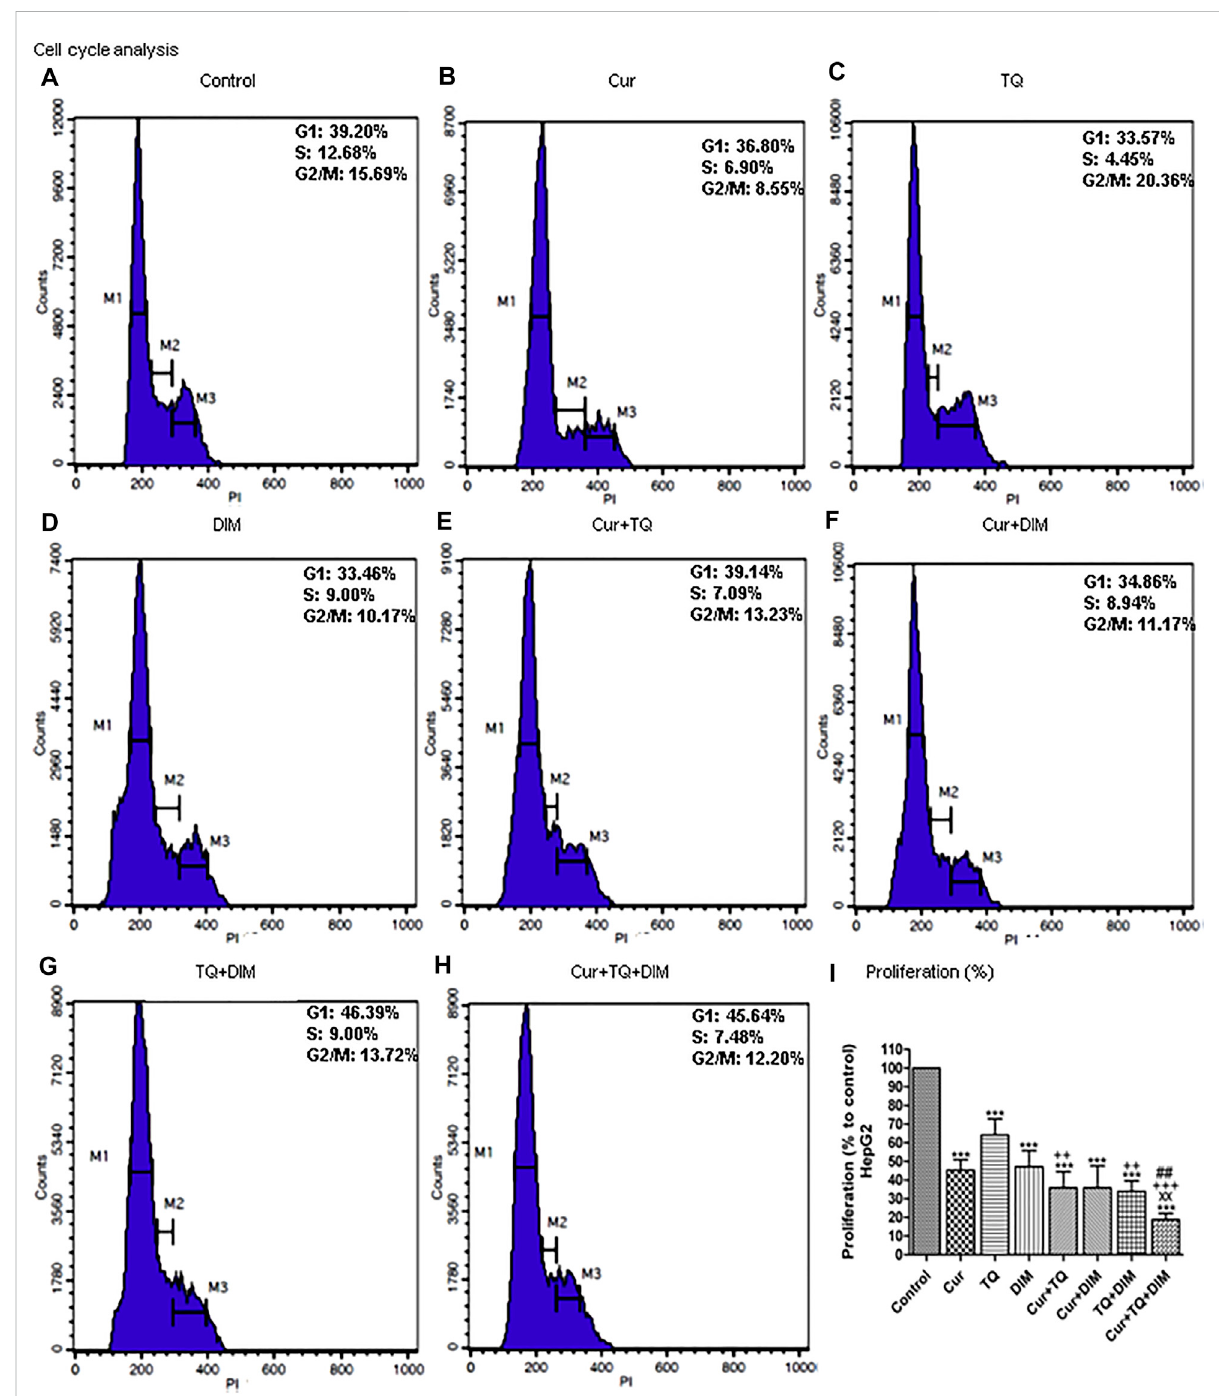
FIGURE 7 Cell cycle analysis and proliferation percentage of HepG2. (A) Cell cycle analysis of control HepG2. (B) Cell cycle analysis of Cur-treated cells with 0.75 (Fa 95) = 15.83 µM. (C) Cell cycle analysis of TQ-treated cells with 0.75 (Fa 95) = 18.71 µM. (D) Cell cycle analysis of DIM-treated cells with 0.75 (Fa 95) = 42.27 µM. (E) Cell cycle analysis of Cur + TQ treated cells with 0.75 (Fa 95) of Cur and TQ. (F) Cell cycle analysis of Cur + DIM treated cells with 0.75 (Fa 95) of Cur and DIM. (G) Cell cycle analysis of TQ + DIM treated cells with 0.75 (Fa 95) of TQ and DIM. (H) Cell cycle analysis of Cur+ TQ + DIM treated cells with 0.75 (Fa 95) of Cur, TQ,and DIM. (I) Proliferation percentages ofcontrol and HepG2-treatedcells with 0.75 (Fa95) of Cur, TQ, DIM, Cur + TQ, Cur + DIM, TQ + DIM, and Cur + TQ + DIM. The data were analyzed with one-way ANOVA followed by Tukey ’ s multiple comparison test. Error bars represent mean ± SD. *** p < 0.001 vs. control. xx P < 0.01 vs. Cur. ++ p < 0.01 and ++ p < 0.01 vs. TQ. ## p < 0.01 vs.